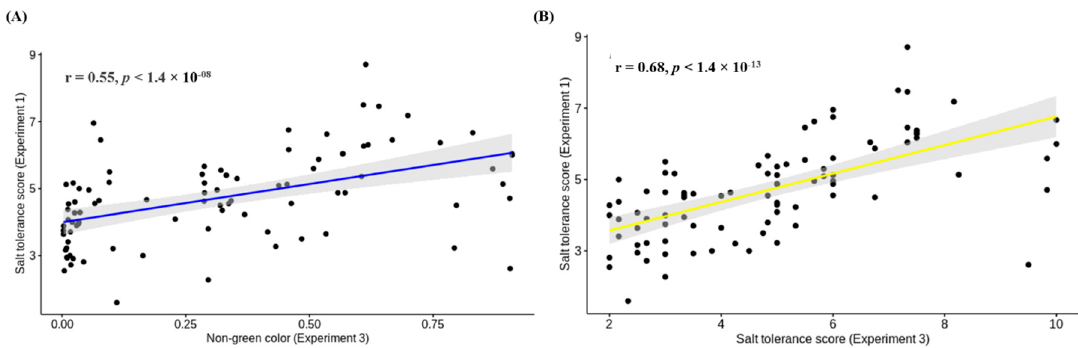
Figure 7. Correlation analysis between Experiments 1 and 3: ( A ) correlation between salt tolerance scores (where 1 is tolerant and 10 is intolerant) from Experiment 1 and non-green color measurements from Experiment 3, and ( B ) Spearman rank correlation between salt tolerance scores from Experiments 1 and 3 .